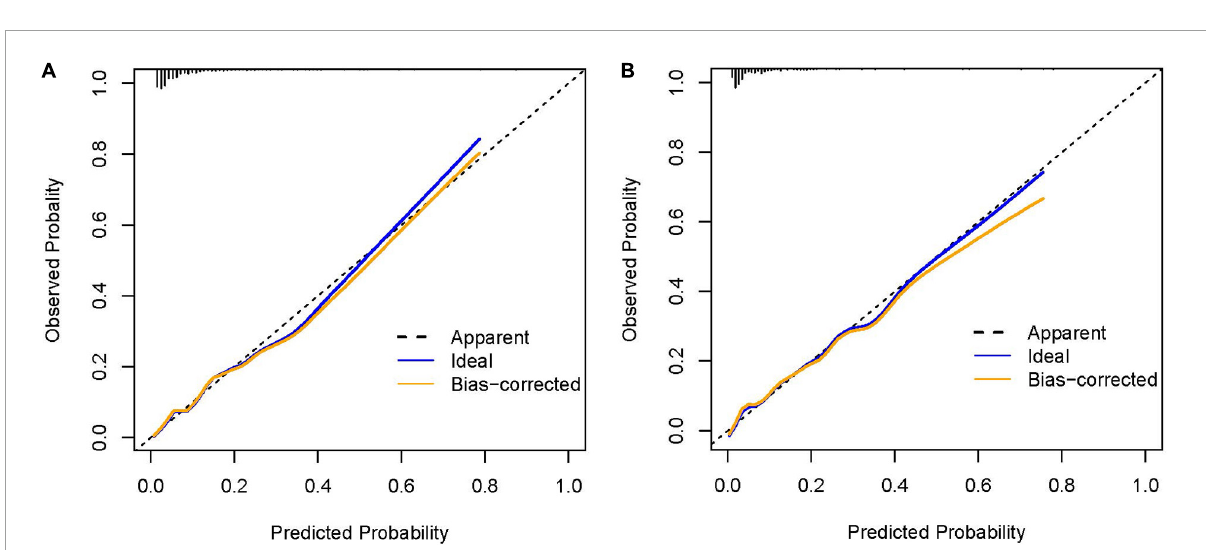
FIGURE5 The calibration curve of the A 2 DS 2 -Nutrition. (A) Calibration curve in the training group; (B) Calibration curve in the validation